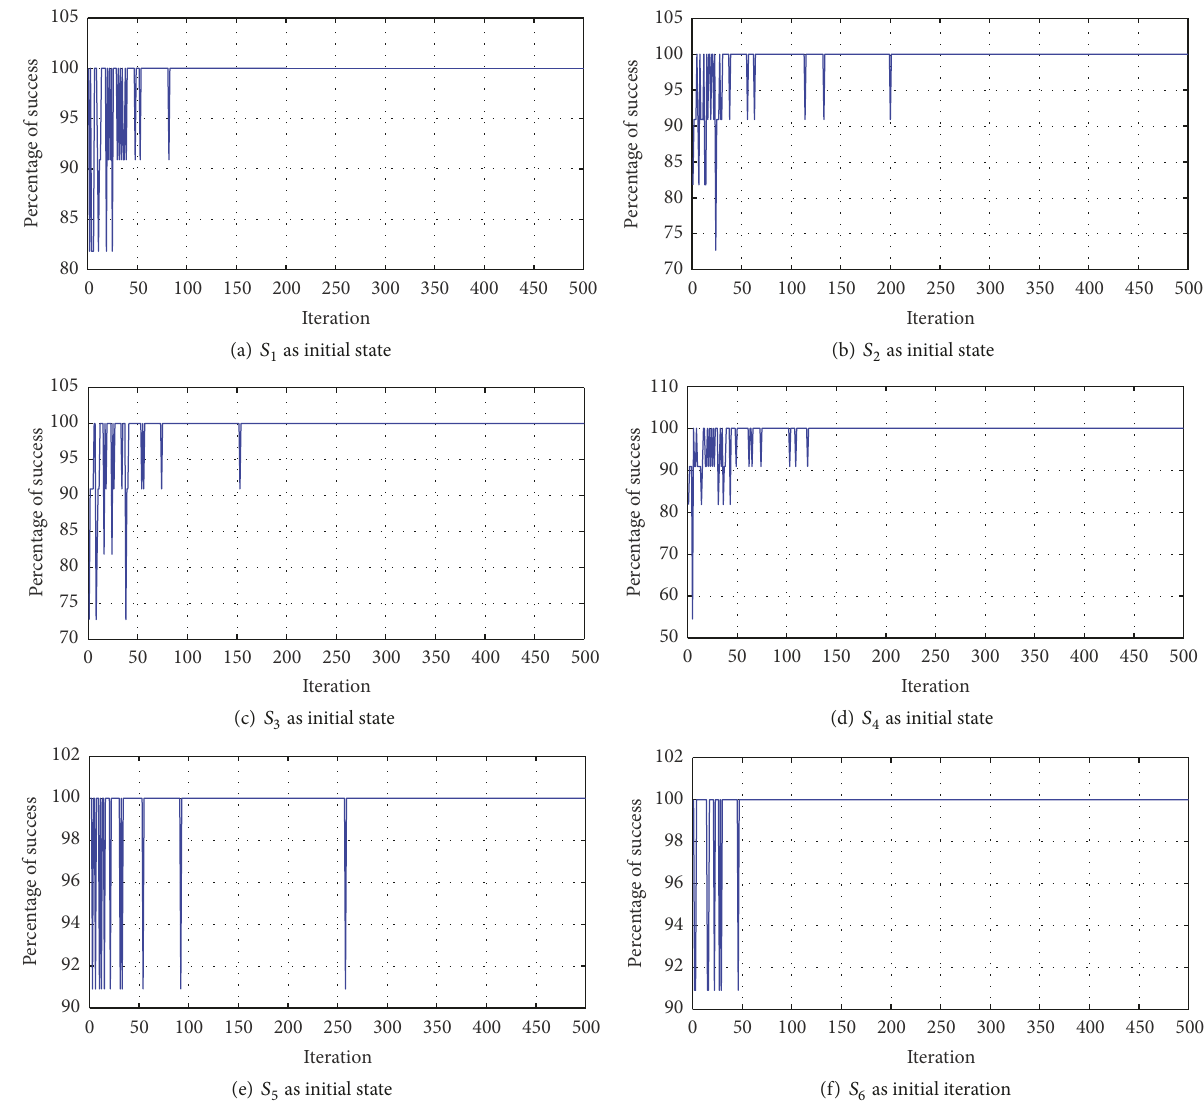
Figure 4: Simulation results for different initial states.